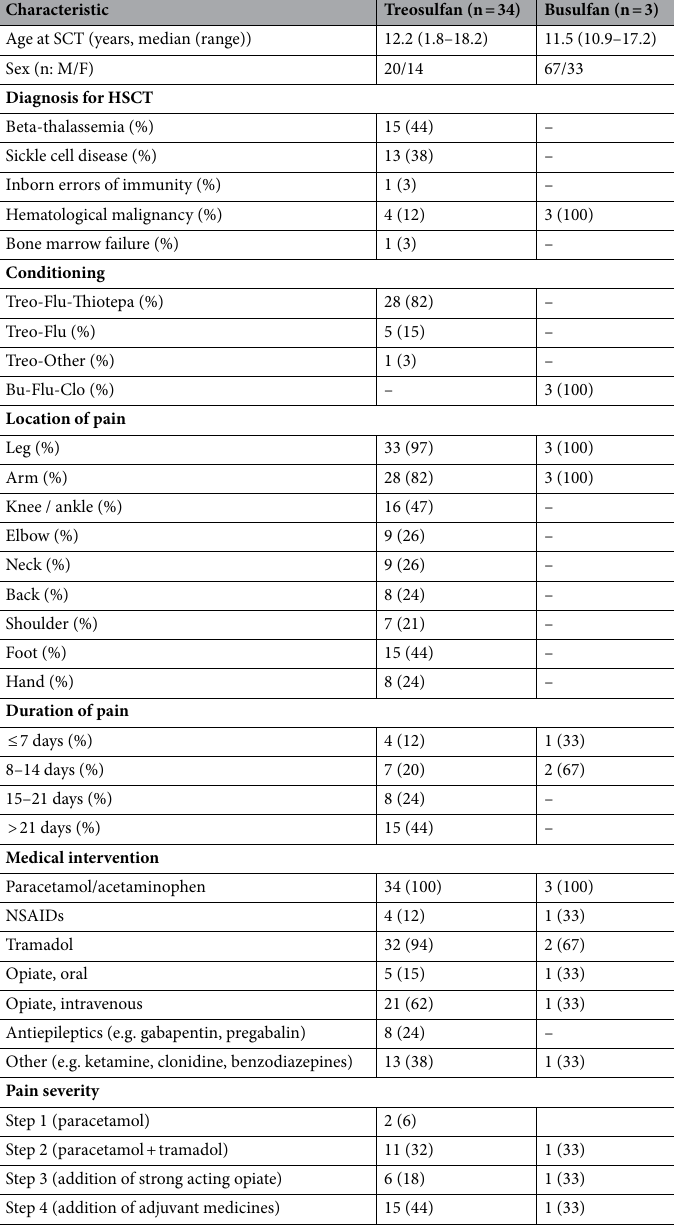
Table 2. Myalgia characteristics in the treosulfan cohort and busulfan cohort. Treo treosulfan, Flu fludarabine, Thio thiotepa, Bu busulfan, Clo